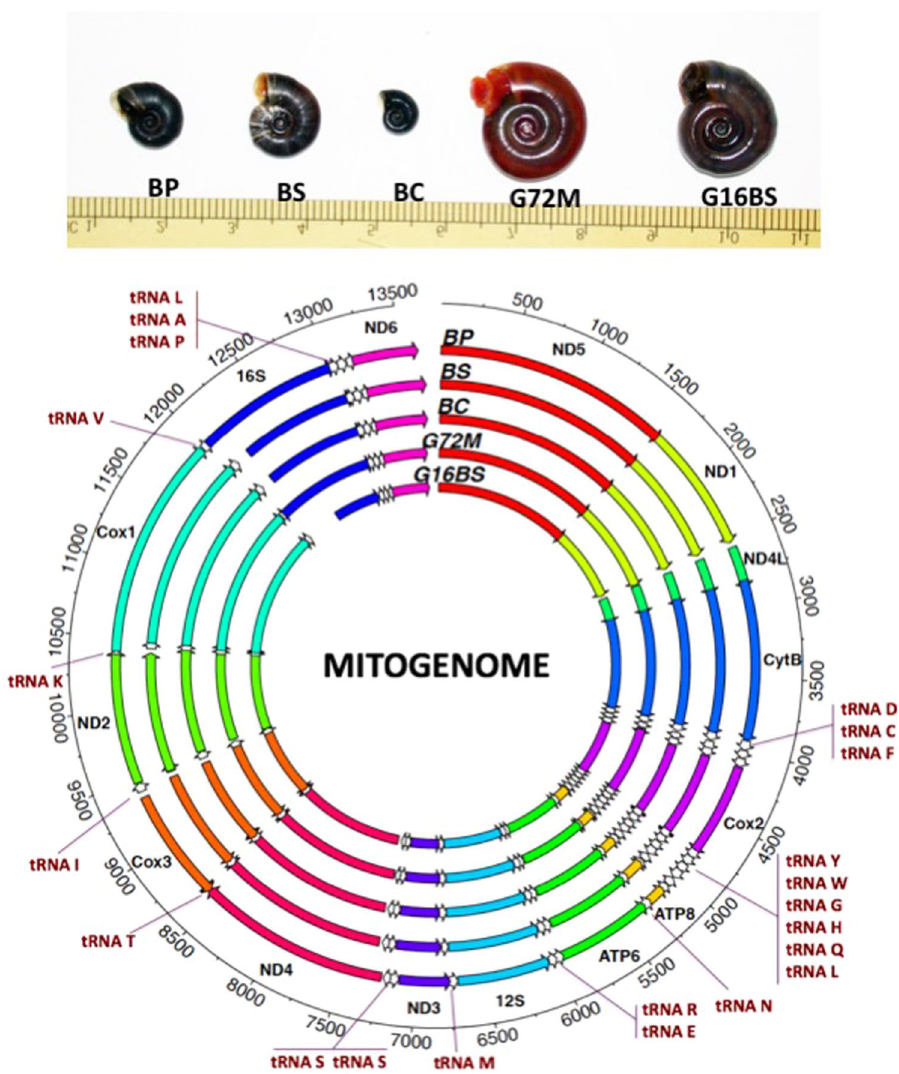
Figure 1. ( A ) Showing the relative size of the five snail specimens. BP: B. pfeifferi ; BS: B . sudanica ; BC: B. choanomphala ; G72M: G72 M line B. glabrata ; G16B: G16 BS90 B. glabrata . ND: NADH dehydrogenase subunit; CytB: cytochrome b; Cox: cytochrome c oxidase subunit. ATP: ATP synthase F0 subunit: 12S: small subunit ribosomal RNA; 16S: large subunit ribosomal RNA; Please note that the abbreviations are applied throughout the paper. ( B ) Showing locations of all genes in the mitogenomes. The detailed information for each gene is presented in Supplementary Dataset Table